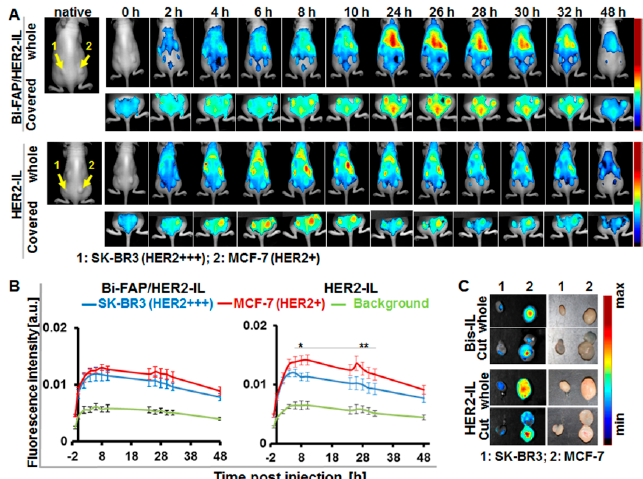
Figure 6. HER2’scFv-liposomes dependent cargo-release enhances NIRF detection of xenografted breast tumor models in mice. ( A ) Representative in vivo NIR-fluorescence images of mice bearing the high HER2-expressing human breast carcinoma model SK-BR3 (left) and low HER2 expressing MCF-7 (right) acquired with the red filter (Exc. 615–665 nm, Em cut-in, >700 nm) at 0–48 h post-injection of the indicated liposomes (Bi-FAP/HER2-IL and the HER2-IL). Images acquired after covering the kidneys and stomach clearly reveal the strong signals of the tumors, which peak at 24–26 h post-injection for Bi-FAP/HER2-IL (in both tumor models) and at 4–6 or 8–10 h for HER2-IL in the SK-BR3 and MCF-7 models, respectively. ( B ) Semiquantitative analysis of fluorescence intensities of tumors at the given time points post-injection. Each point depicts the mean of fluorescence intensities of regions of interest (ROIs) placed on the respective tumors (SK-BR3 and MCF-7) or background (thigh region) at the indicated time points after unmixing the auto-fluorescence. Each group constitutes n = 5 mice ± SEM. p < 0.05 for MCF-7 versus SK-BR3 at time points 8–10 (*) and 26–32 h (**) post-injection of HER2-IL, whereas accumulation of Bi-FAP/HER2-IL in SK-BR3 and MCF-7 models show no significant difference. ( C ) Representative NIR-fluorescence images and photographs of tumors (whole and cut) excised at 48 h post liposomal injection still reveal liposomal